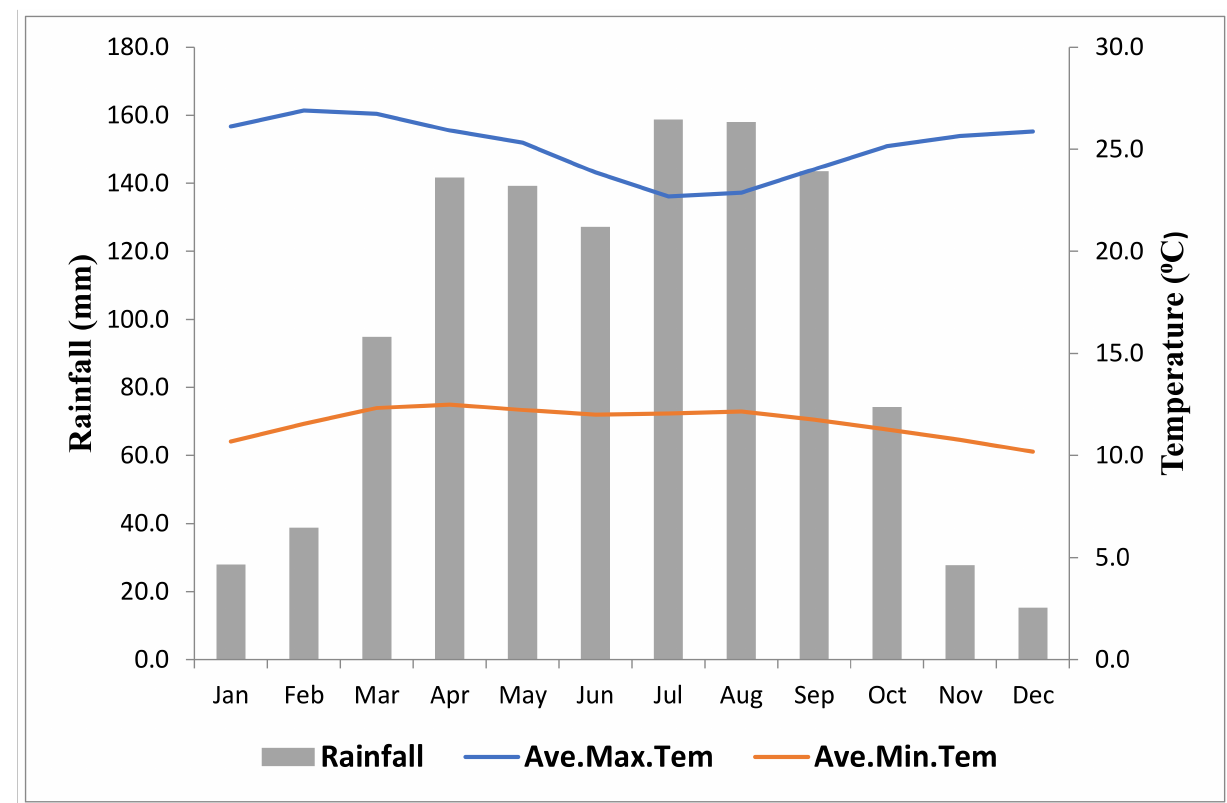
Figure 2. Mean monthly rainfall and temperature of the study area